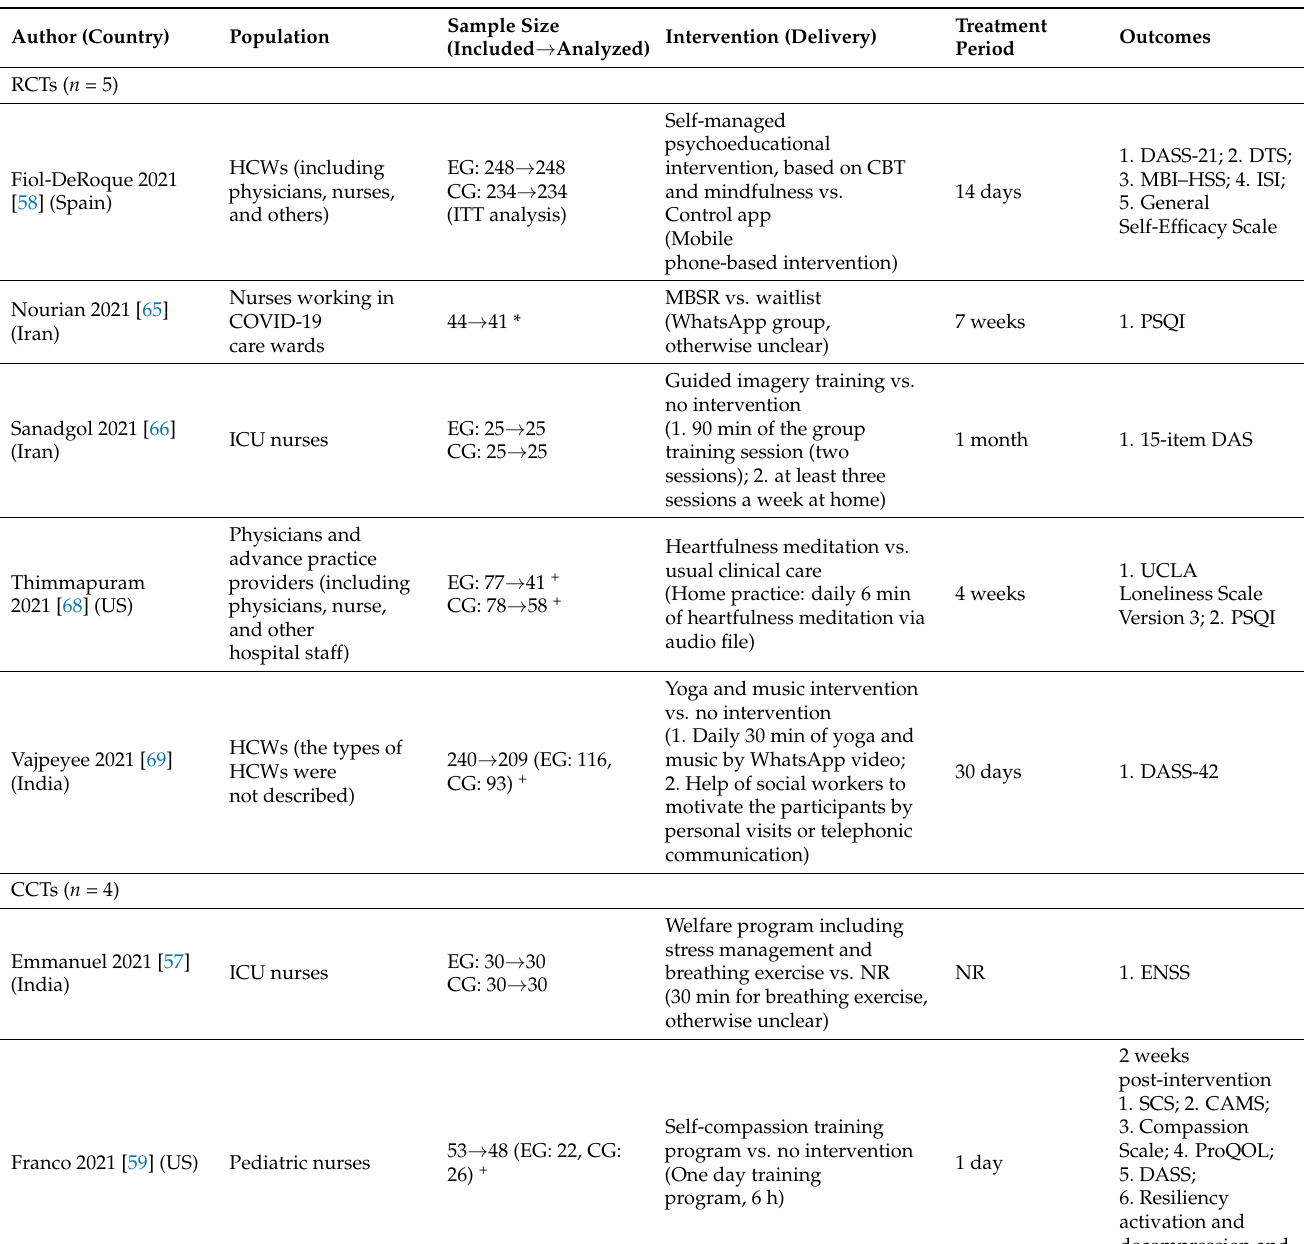
Table 1. Characteristics of included